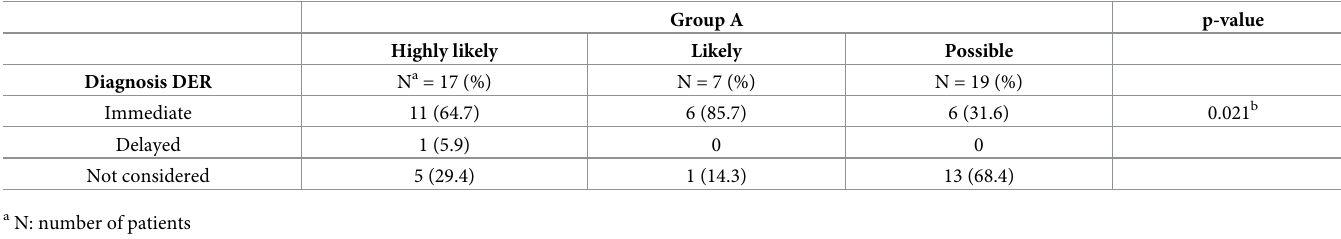
Table 2. Consideration of the diagnosis of DER by the treating physician in patients with a history of DIS treatment and ethanol use admitted to the ED of the Uni- versity Hospital of Ghent between October 1, 2010 and September 30,